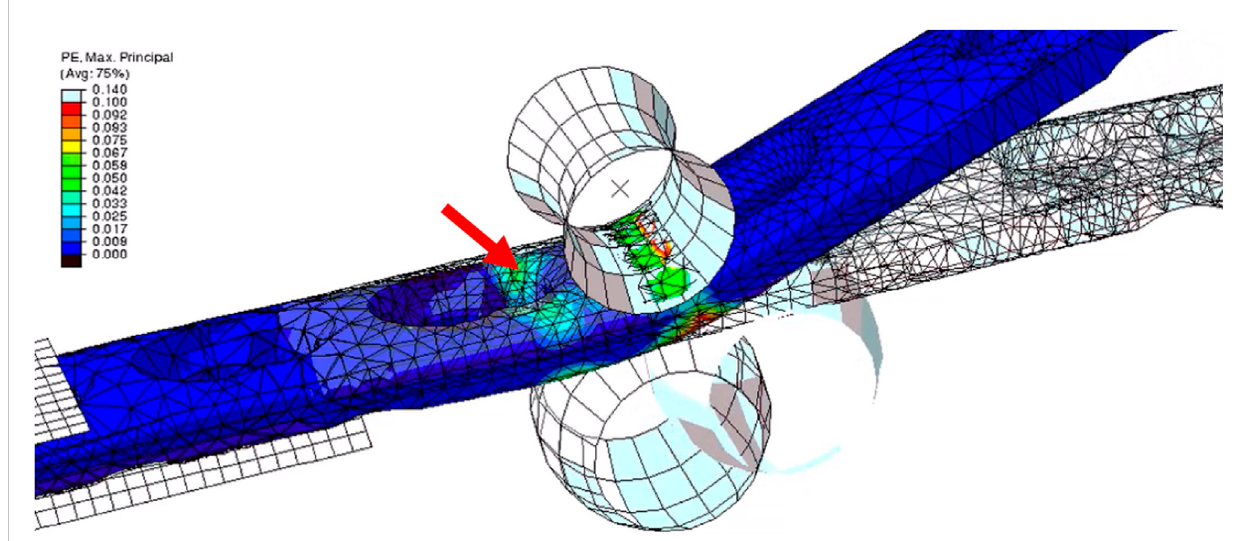
FIGURE 6 Finite element analysis of the plate pre-bending process demonstrating residual stresses after its completion (Zderic et al., 2021). Residual stresses also exist around the distal radial locking screw hole, as indicated by the red arrow, and are not limited to the bending